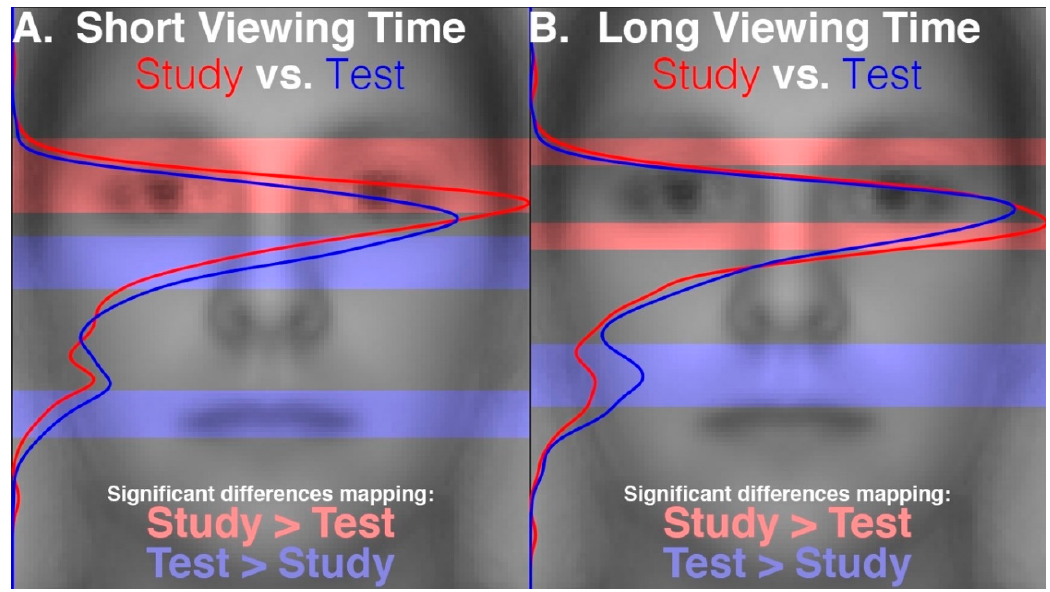
Figure 6. Study versus test phase vertical-profile density curves and statistical contrasts for the second ordinal fixation, separated by ( A ) the short presentation time condition; and ( B ) the long presentation time condition. The face image is highlighted where relative vertical density was significantly different (q < 0.05) between the contrasted conditions. Curves are scaled relative to the maximum density between the two given contrasted curves. The densities are only interpretable relative to one another and are dimensionless quantities; therefore, no units or absolute values are reported.